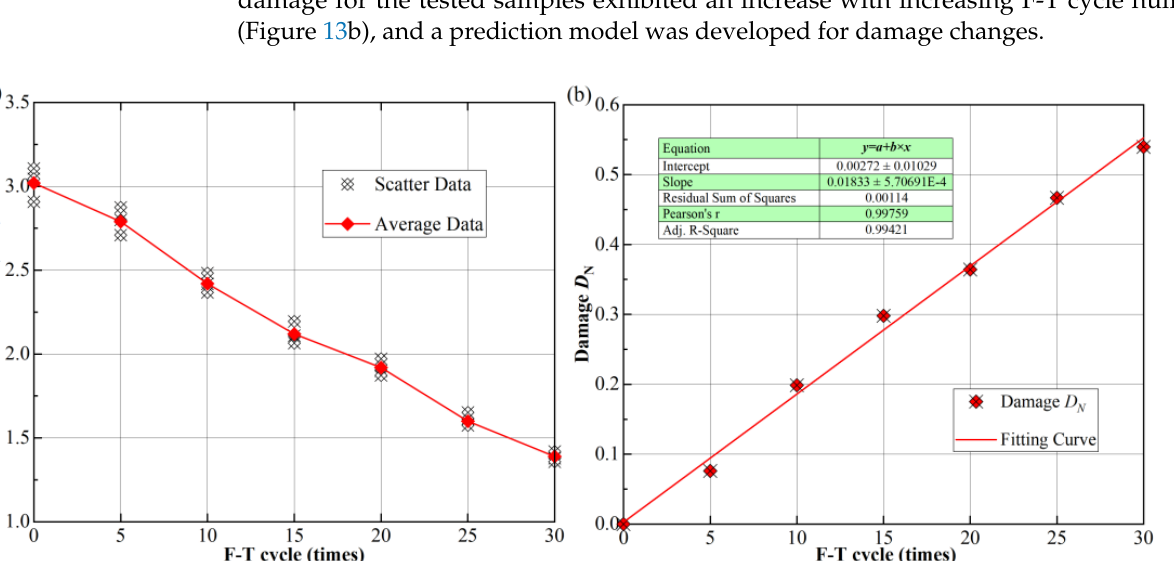
Figure 12. F-T damage mechanism.